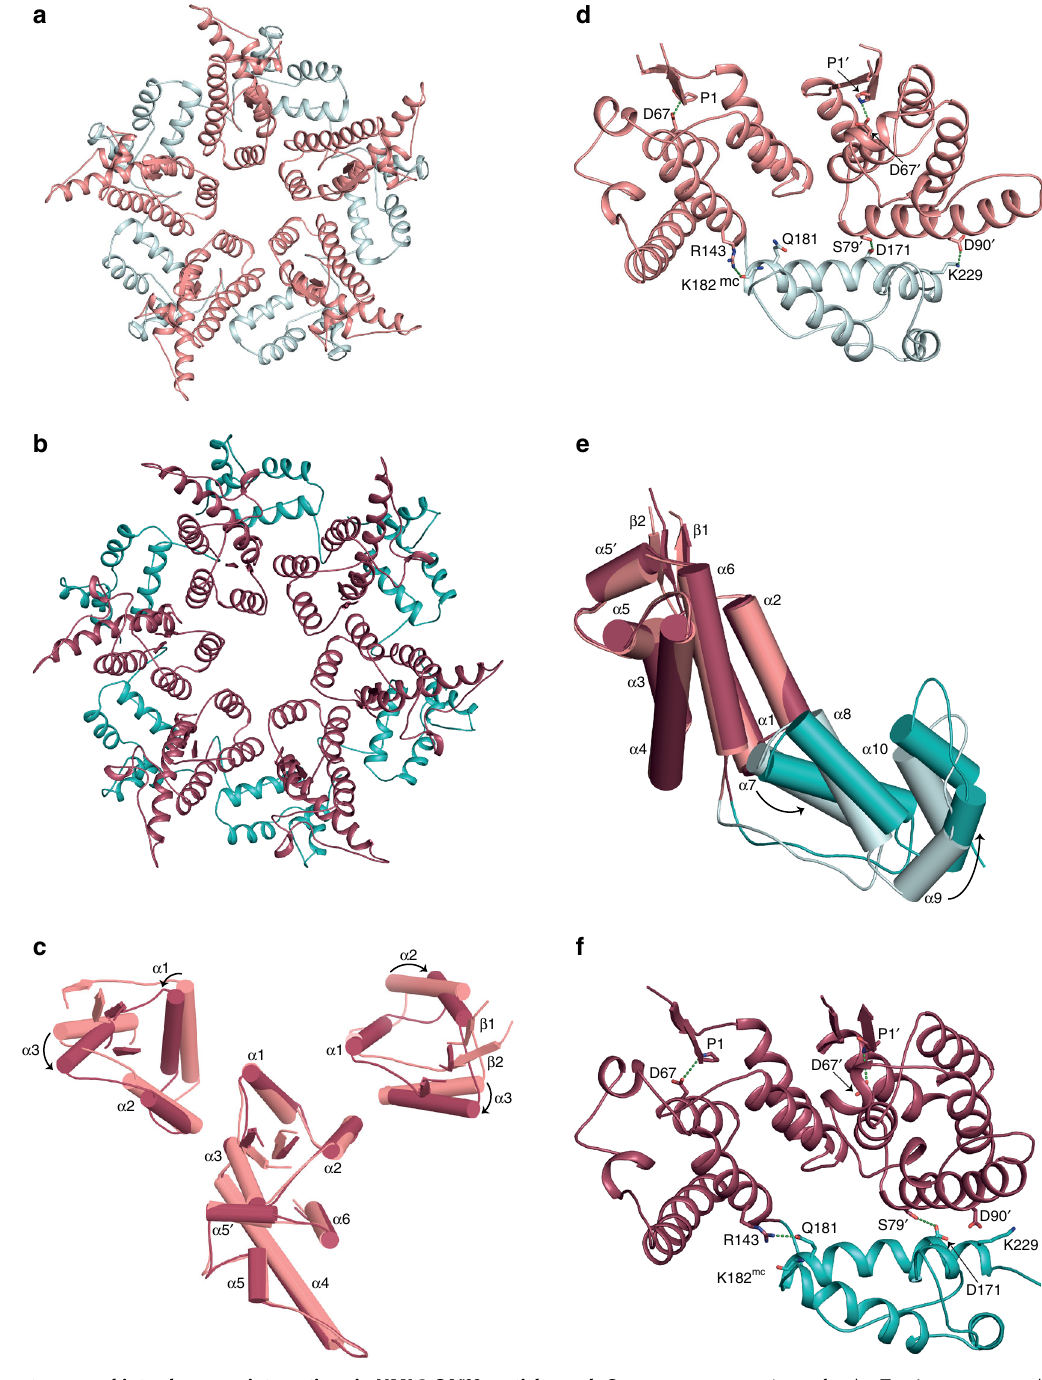
Fig. 4 Intra-pentamer and intra-hexamer interactions in HML2 CA rec particles. a , b Cartoon representations of a the T = 1 pentamer and b the D6 polar hexamer viewed along the fi ve-fold and six-fold symmetry axes, respectively. The NTDs and CTDs are coloured as in Fig. 2. c Alignment of the NTDs from a T = 1 pentamer (pink) and a D6 “ polar ” hexamer (red). The central NTD is aligned and the arrows indicate the relative displacement of helices α 1, α 2 and α 3 in adjacent monomers at the intra-pentamer or intra-hexamer interface. d NTD – CTD interactions in the T = 1 pentamer. e NTD domain superposition showing the relative displacement of the CTD in the T = 1 pentamer (pink/cyan) and the D6 “ polar ” hexamer (red/teal). f NTD – CTD interactions in the D6 polar hexamer. In d , f residues making interactions are shown as sticks, with hydrogen bonds shown as dashes, the prime ( ′ ) notation indicates the adjacent NTD and “ mc ” indicates a main-chain interaction. The conserved N-terminal P1 to α 3 – D67 interaction is also shown in each NTD for